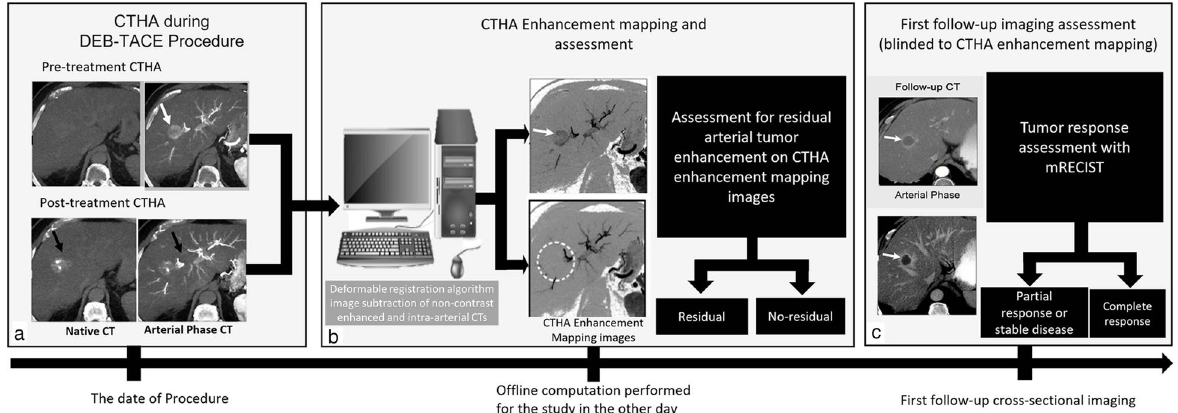
Fig. 2 Schematic illustration of proposed CTHA‑EM method to predict hepatocellular carcinoma response to DEB‑TACE. a CTHA image acquisition during DEB‑TACE consists of dual‑phase CT (native‑ and contrast‑enhanced arterial phases) acquired before and after DEB‑TACE.